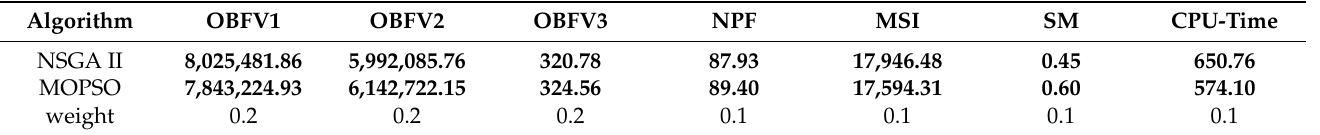
Table 15. The results of TOPSIS